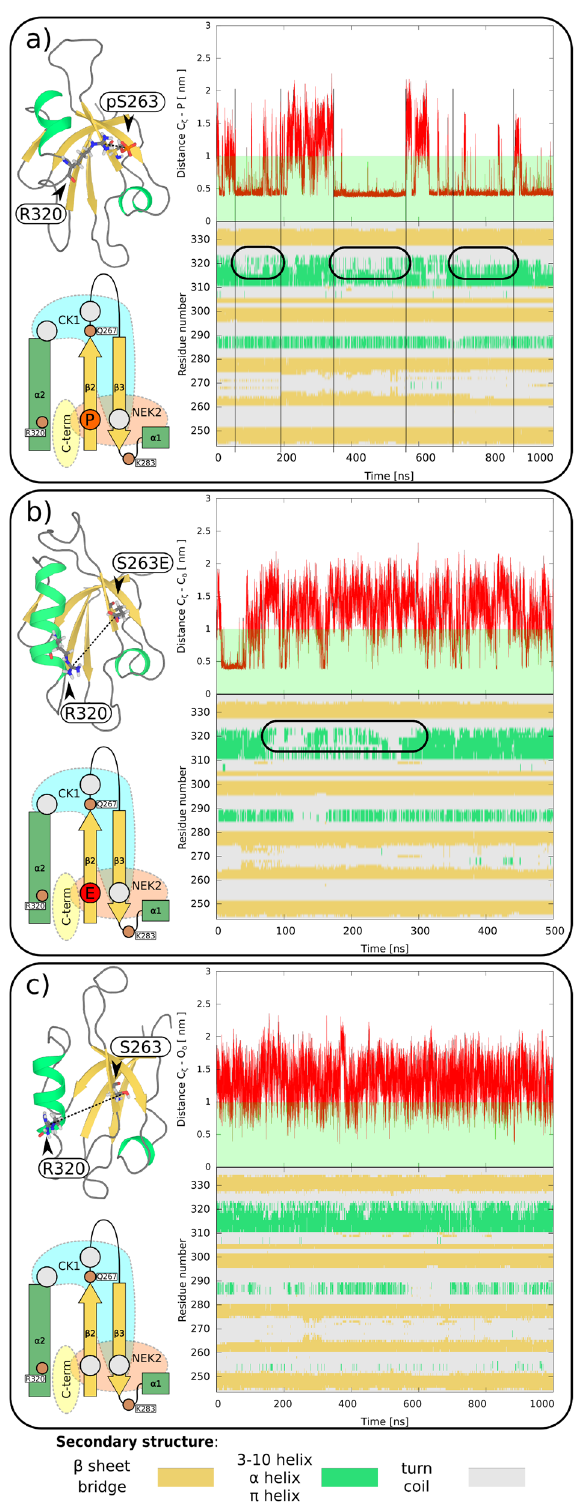
Figure 3. Effects of ( a ) the phosphoserine pS263 and ( b ) the phospho mimetic S263E on the PDZ structure, ( c ) show interactions in wt for comparison. In each panel: top left—system snapshot; bottom left—schematic representation; top right—time evolution of the distance between C ζ atom in R320 and P/ C δ / O δ atoms in pS263/ S263E/wt, respectively; and bottom right—the time evolution of the PDZ secondary structure (color coding: below the